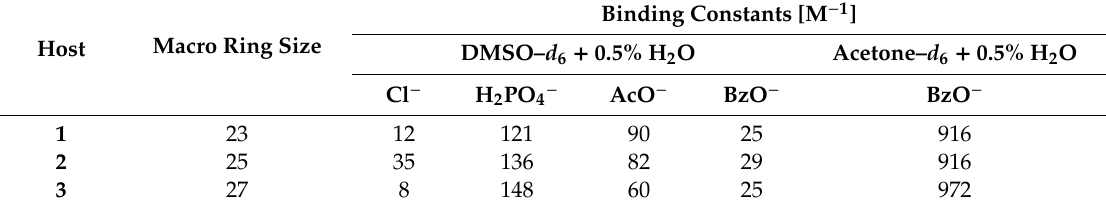
+ 0.5% H + 6 2 O mixture and acetone– d 6